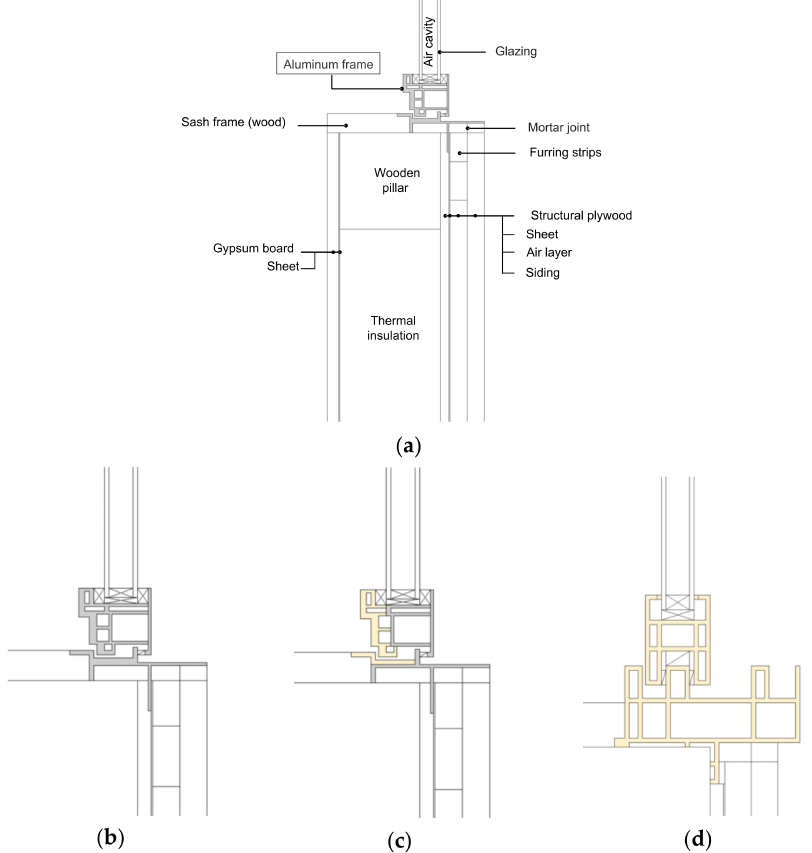
Figure 1. Cross-section of ( a ) aluminum frame including wall, ( b ) aluminum frame, ( c ) composite frame (aluminum and polyvinyl chloride [PVC]), and ( d ) PVC